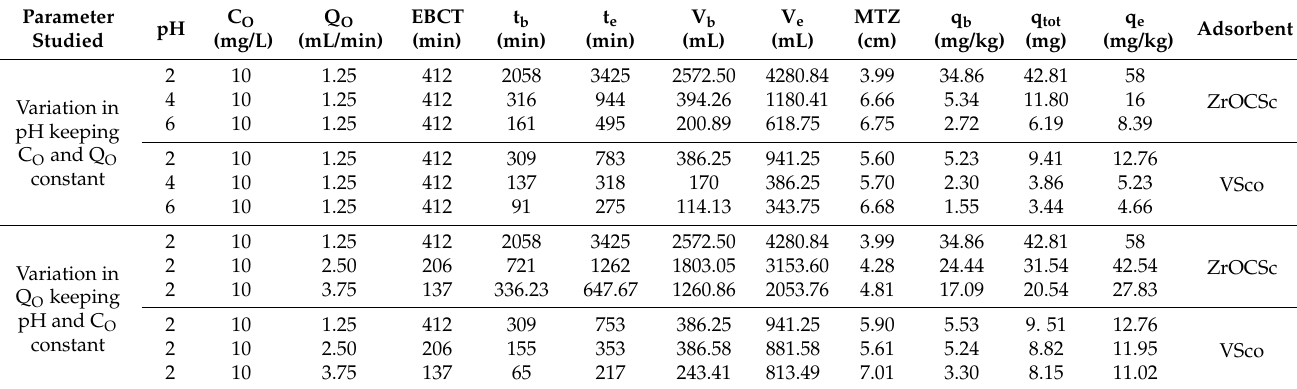
Table 2. Fixed-bed column parameters obtained for defluoridation by VSco and